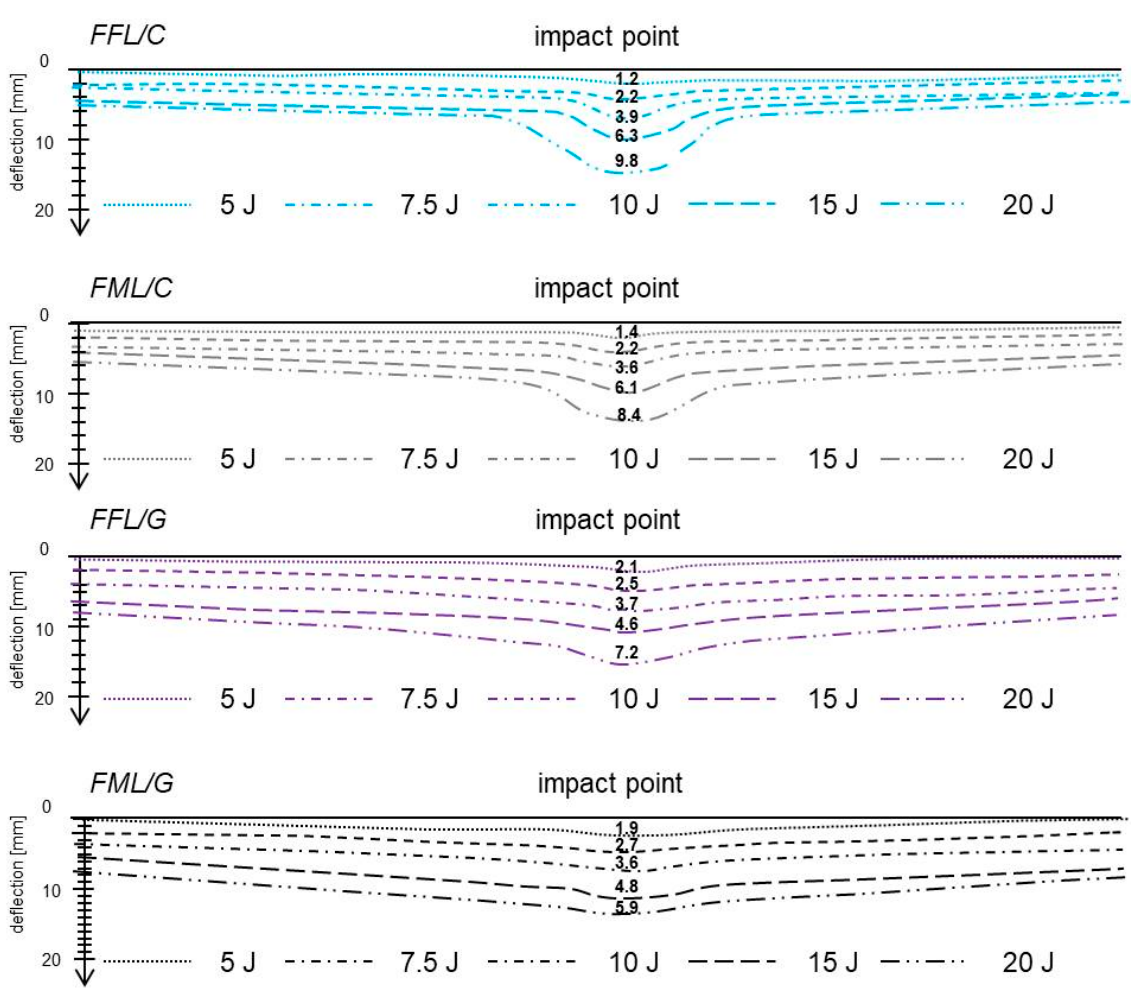
Figure 11. Deflection profiles of the top edge of laminates after impact. It was observed that in the carbon–based and glass–based laminates deflection in- creases with increasing impact energy. In general, higher values of deflection were measured in carbon laminates than in glass laminates, due to the low strain to failure of carbon fibres (cracked fibres reduce significantly the laminate stiffness, which causes a greater energy absorption of the metal components, i.e., causes greater plastic defor- mation of the metal layers) [3]. The values of permanent deformation of foam fibre metal laminates and conventional laminates are not significantly different. The permanent de- flection varies between the 1.2 and 9.8 mm for FFL/C, and between 1.4 and 8.4 mm for FML/C. In the case of glass–based laminates, the values vary between 2.1 to 7.2 and 1.9 to 5.9 for FFL/G and FML/G respectively. The most significant difference occurs in the shape of the deflection profile. In fibre metal laminates deflection at the impact point has